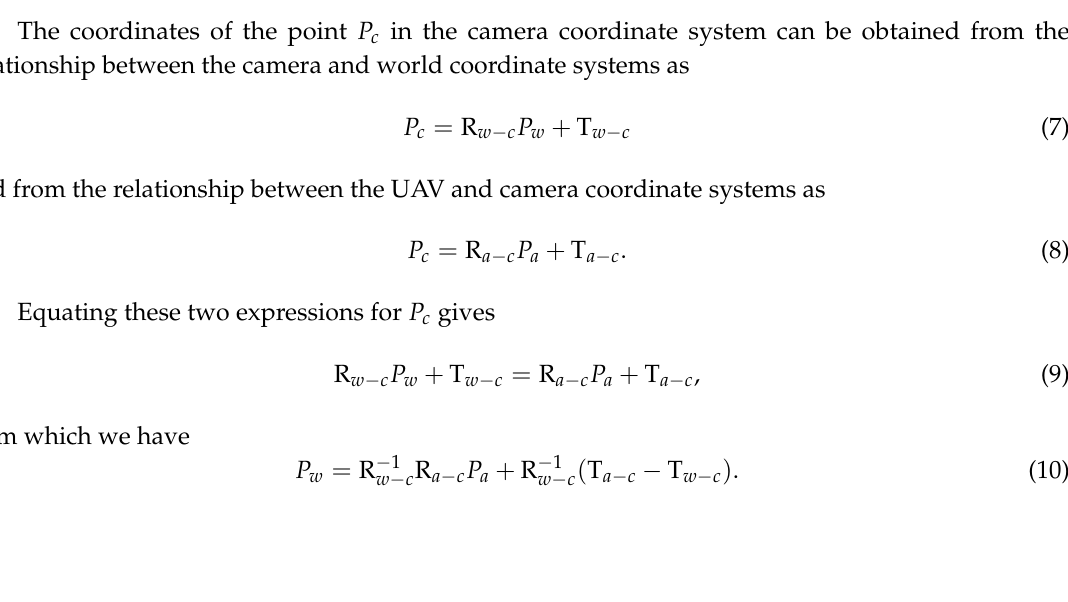
Figure 4. The relationship between the UAV coordinate system and the world coordinate